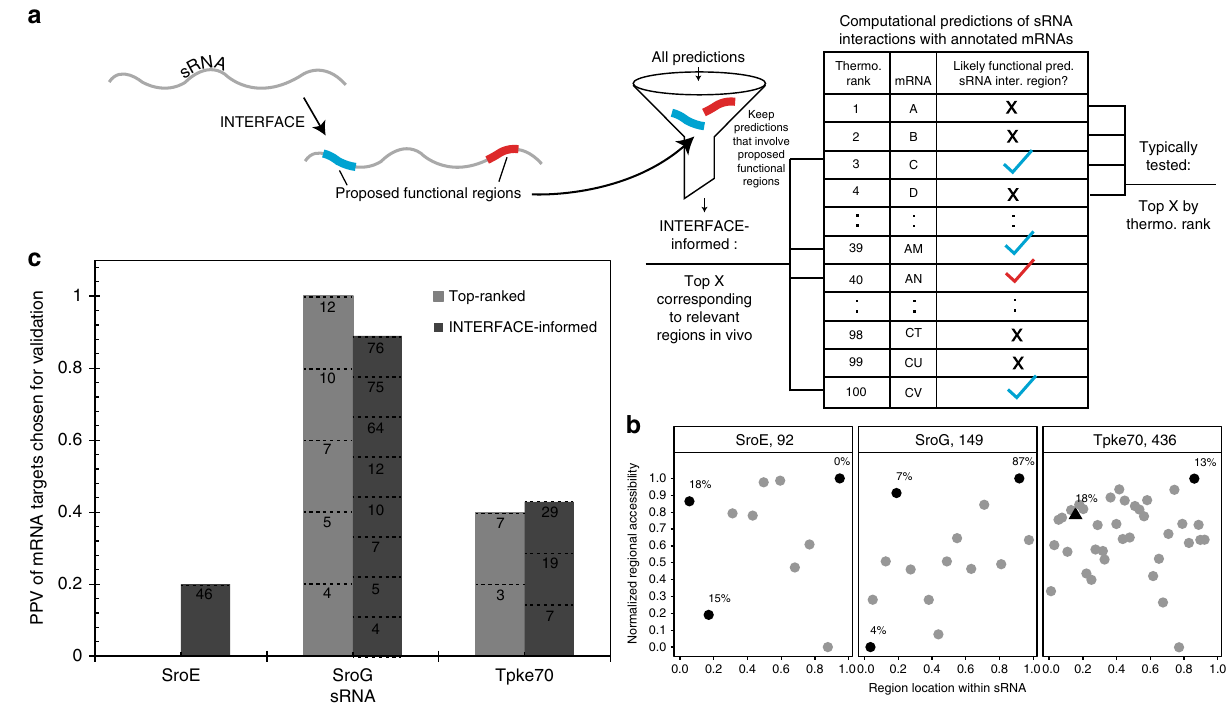
Fig. 4 Benchmarking the use of INTERFACE for selection of “ true ” predicted target mRNAs of under-characterized sRNAs. a INTERFACE data, along with position and motif information, allows fi ltration of a pool of sRNA regions targeted for the selection of likely functional regions. Speci fi cally, likely functional regions are chosen as those that exhibit accessibility values within extremes chosen for benchmarking (>0.75 or <0.25), 5 ′ - or 3 ′ -end position, and, in rare circumstances, the presence of a YUNR motif (see Methods). These likely functional regions can be used to inform computational mRNA target predictions for sRNAs to suggest positive binding partners (INTERFACE-informed, left of table) that may not typically be chosen for experimental validation (top- ranked, right of table) due to low energetic favorability. b Regional position versus accessibility for three representative uncharacterized sRNAs selected for benchmarking of computational mRNA predictions. Dark gray regions correspond to likely functional regions, chosen for their extreme accessibilities in the 5 ′ or 3 ′ 20% end of the transcript. In the case of accessibility clustering, presence of a YUNR motif is indicated by a triange. Percentages of predicted mRNA target interactions within top 100 computational predictions that involve the likely functional regions are listed beside the corresponding region. c Positive predictive values (PPV) of computationally predicted binding partners for three representative uncharacterized sRNAs as evaluated using EMSA. Numbers within bars correspond to the ranking (out of 100) of all con fi rmed mRNA interaction partners for each prediction category (INTERFACE- informed v. top-ranked). For SroE, one mRNA target from the INTERFACE-informed group (ranking 46/100 in IntaRNA predictions) was con fi rmed via EMSA, although none of the top-ranked IntaRNA predicted targets tested (within top 12/100) exhibit sRNA binding (Supplementary Fig. 5). For SroG, INTERFACE correctly pinpoints a region implicated in many of the top predictions (Fig. 3b), further giving con fi dence to these as true partners, and also pinpoints lowly ranked targets via the two proposed functional regions at the 5 ′ -end (Fig. 3b). Finally, considerable overlap between INTERFACE-informed predictions and top-ranked tested IntaRNA predictions (within top 14/100 rank) of Tpke70 led to the con fi rmation of mcrA as a target (Table 1). Importantly, IntaRNA correctly predicts a con fi rmed weak target ( agaS ) to interact with a region not captured by the INTERFACE-informed